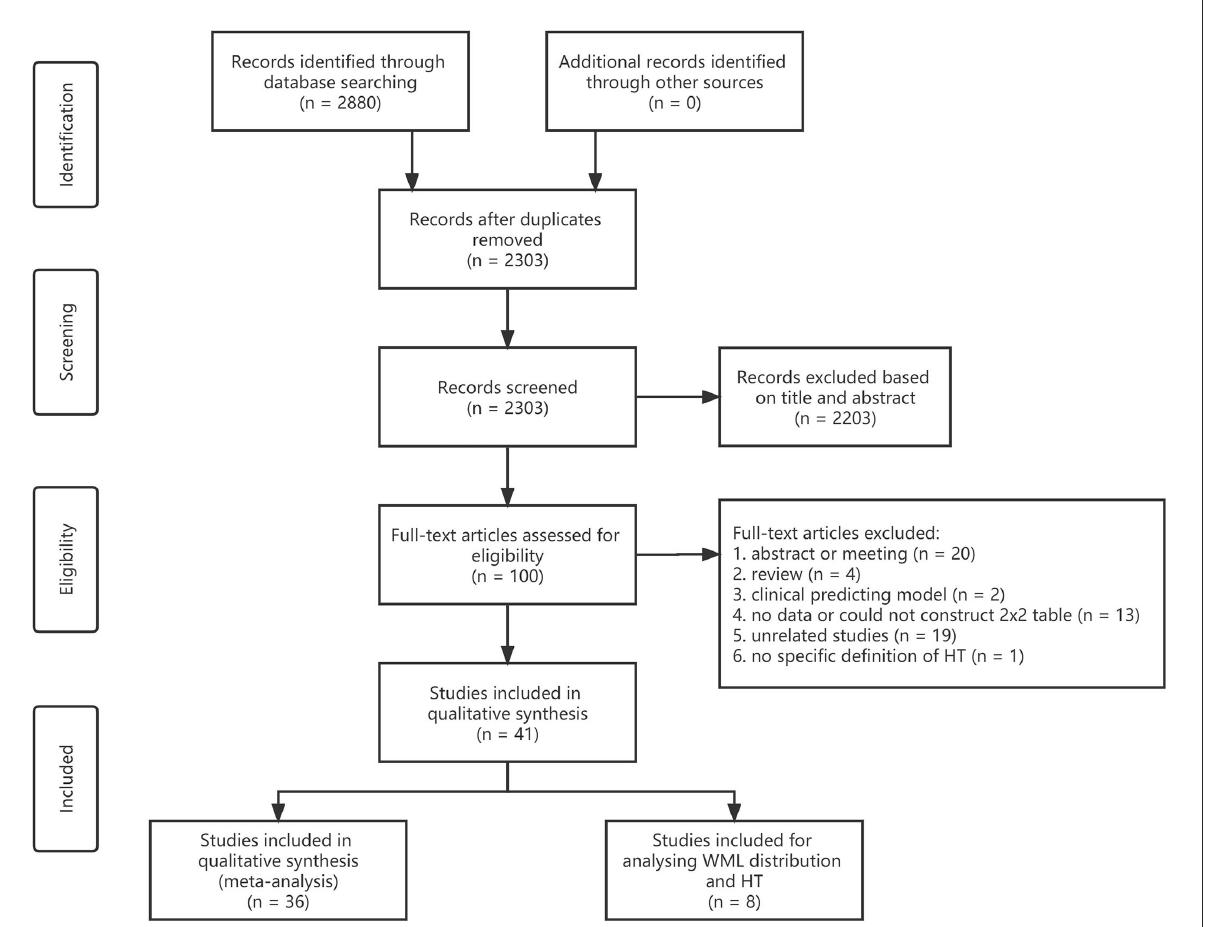
FIGURE1 Flowchart of the literature search and study selection. WML, white matter lesion; HT, hemorrhagic transformation.